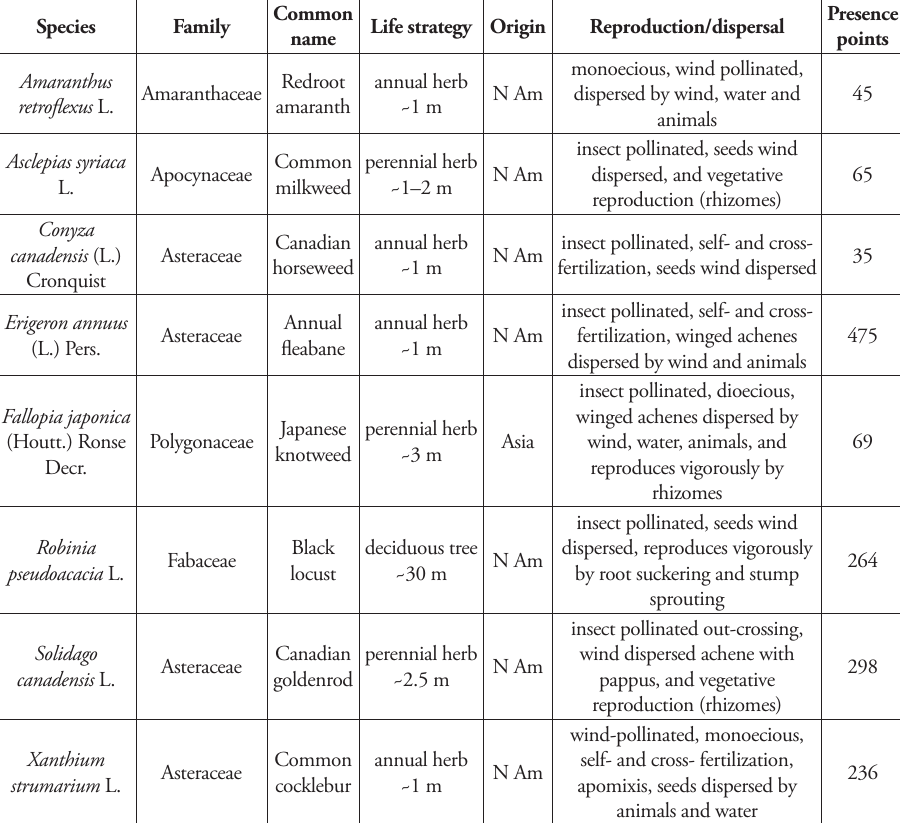
Table 1. Overview of study species and number of sampling points (N Am = North